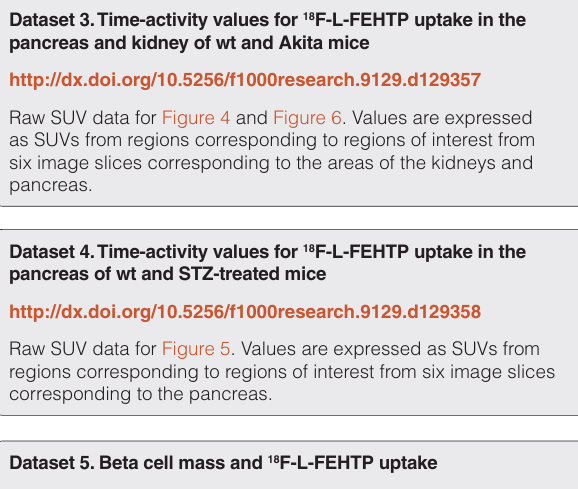
Raw SUV data for Figure 4 and Figure 6. Values are expressed as SUVs from regions corresponding to regions of interest from six image slices corresponding to the areas of the kidneys and pancreas.